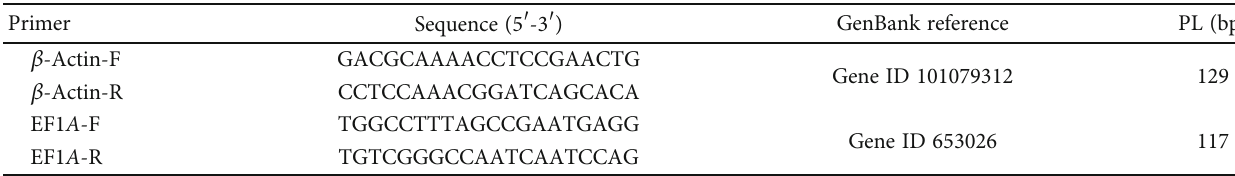
Table 4: Growth performances and somatic parameters of experimental tiger pu ff er ( mean ± standard error ). Parameters